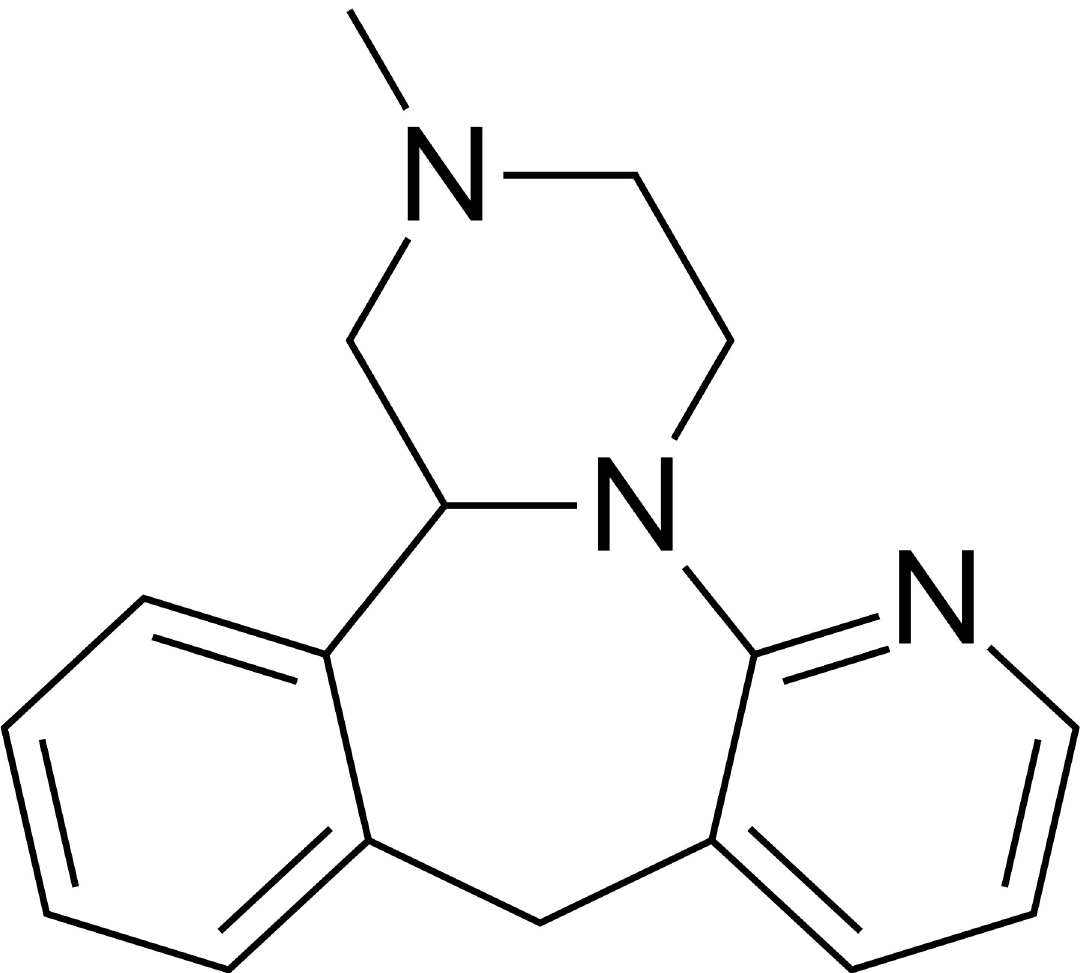
Fig 1. Chemical structure of